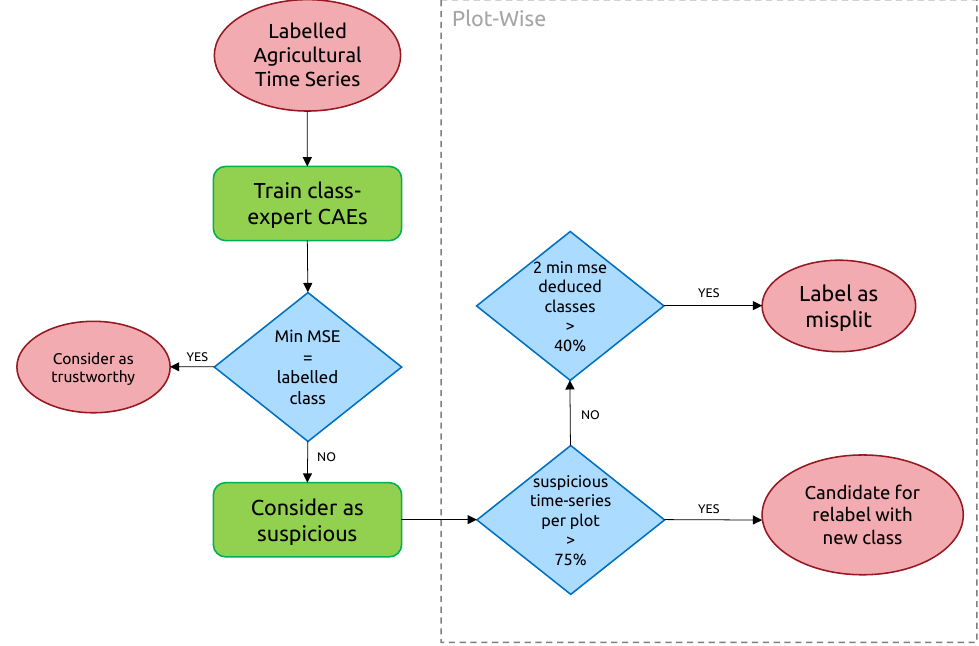
Figure 6. Methodology for the detection of mis-split and mislabeled crops with a pixel-wise time series-level analysis at first, followed by a crop-level